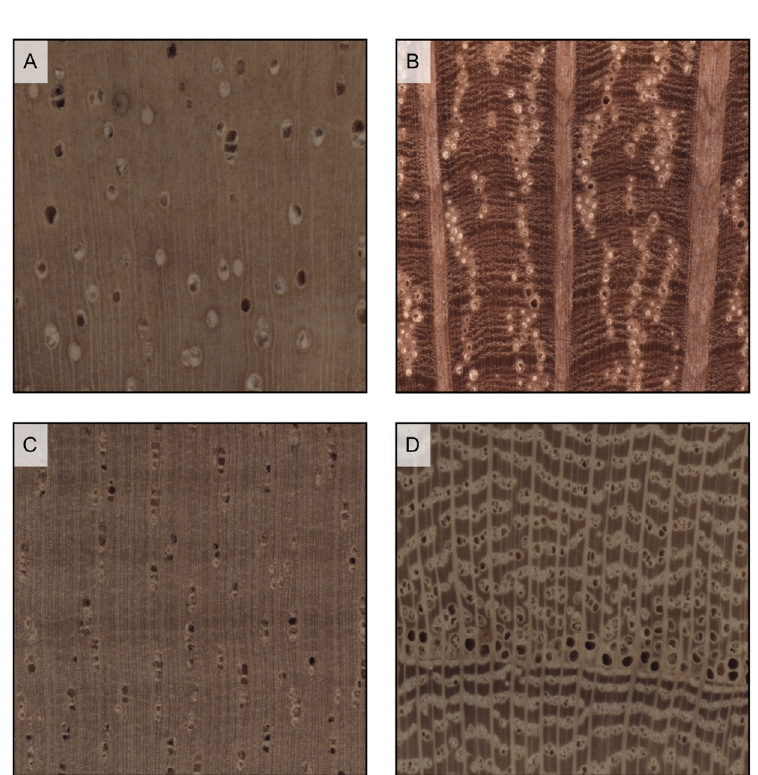
Table 14. Examples of species for different vessel frequencies.